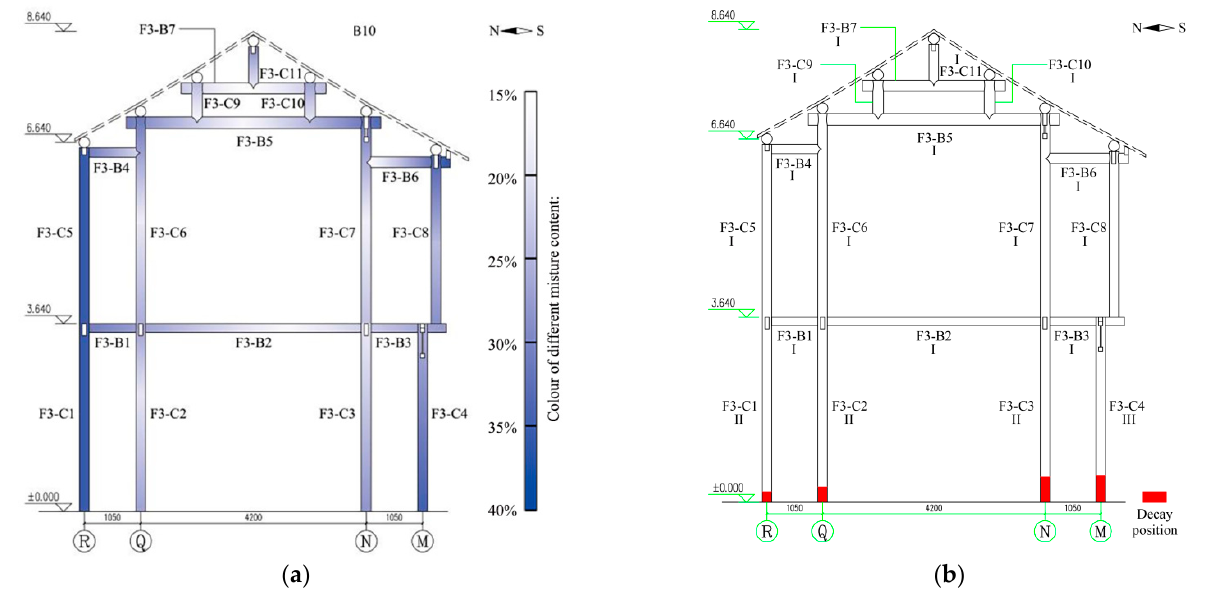
Figure 14. Moisture content and decay of F3 in Fujiu Zhou house; ( a ) schematic diagram of moisture content; ( b ) schematic diagram of decay position and decay grade.